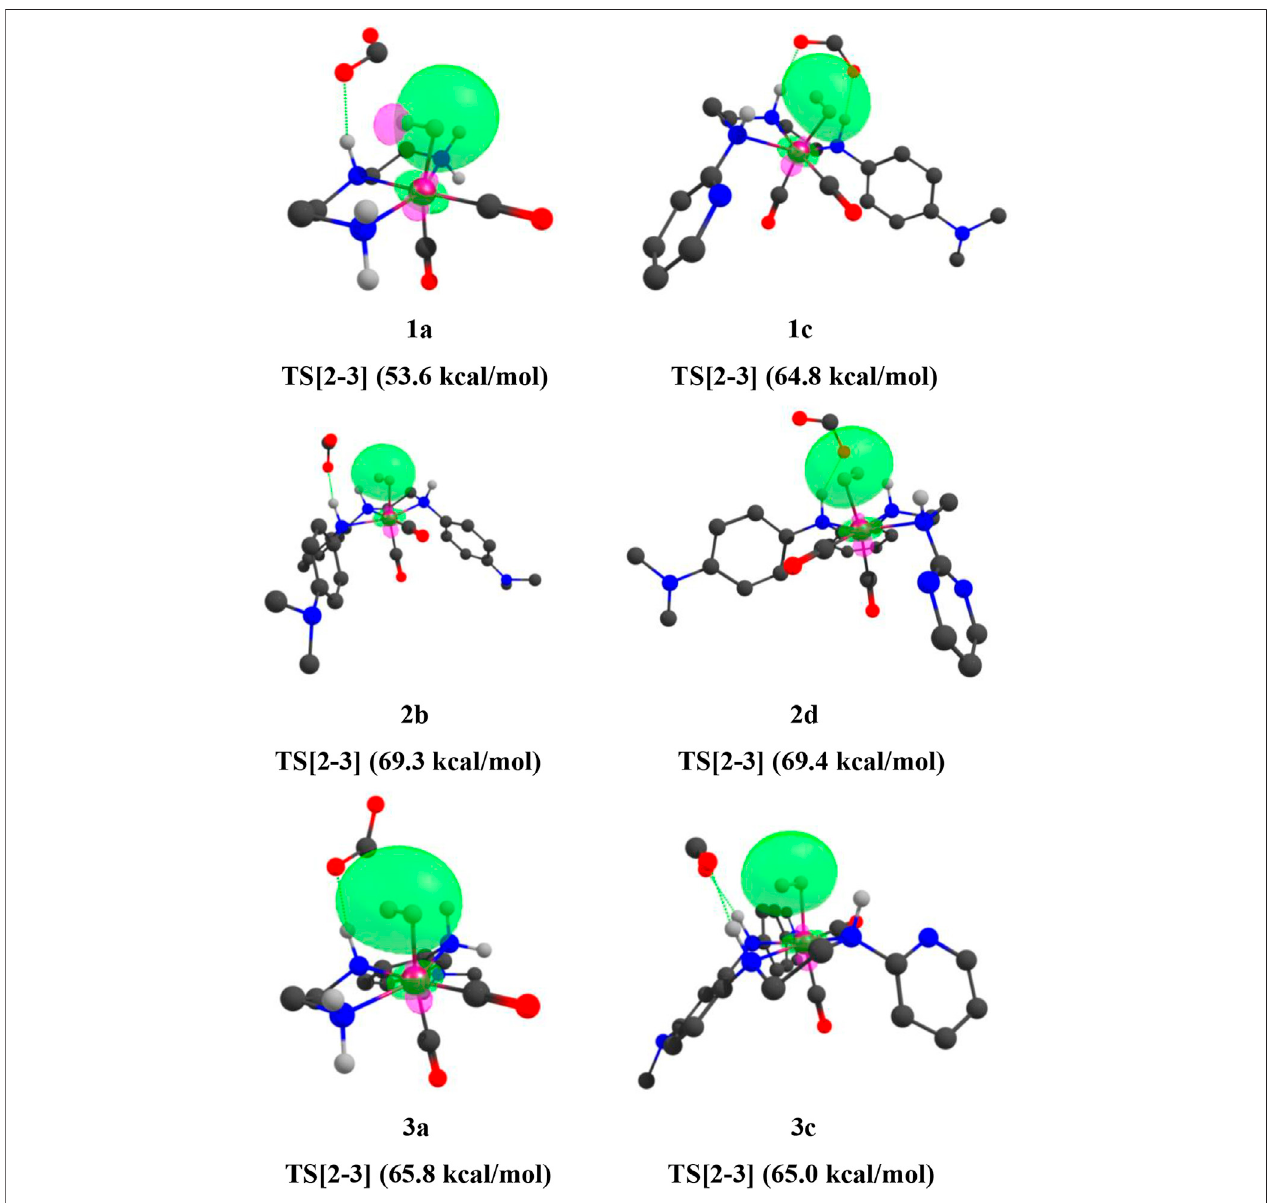
FIGURE 14 | Mn — H 2 interaction NBOs of IN4 of catalysts 1a, 1d, 1e, 2a, 2b, 2e , and 3a (isovalue (cid:1) 0.03). Interaction energies are indicated in parentheses. The structures are visualized using the Chemcraft software (Chemcraft, 2021) (NBO for all catalysts are given in Supplementary Data Sheet S1 ).